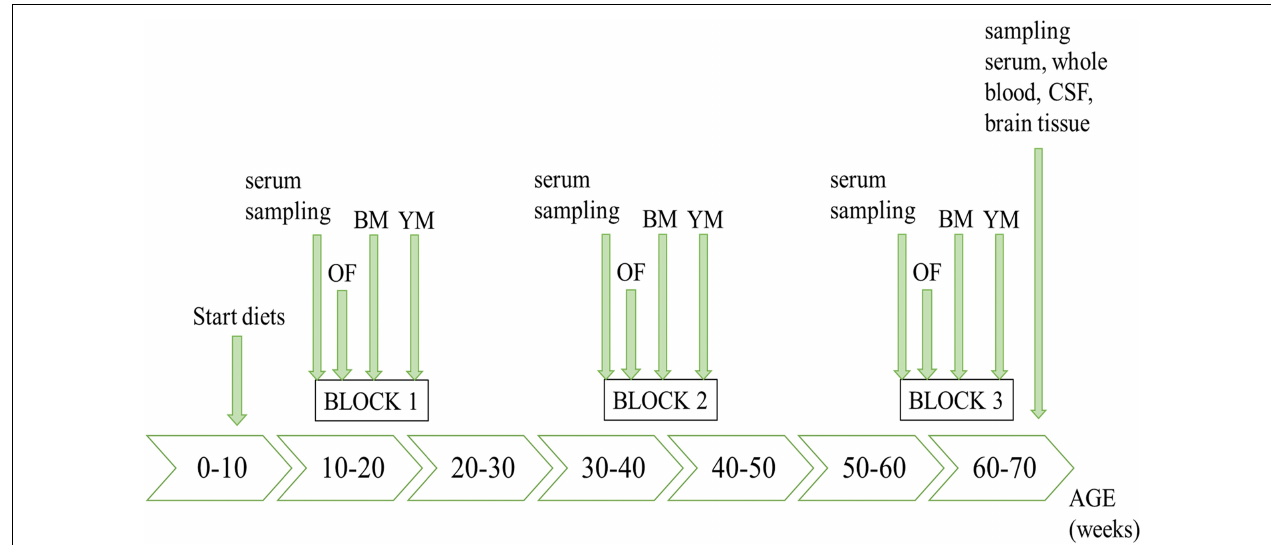
FIGURE 1 | Timeline of the in vivo experiments. OF, open field test; BM, Barnes maze; YM,